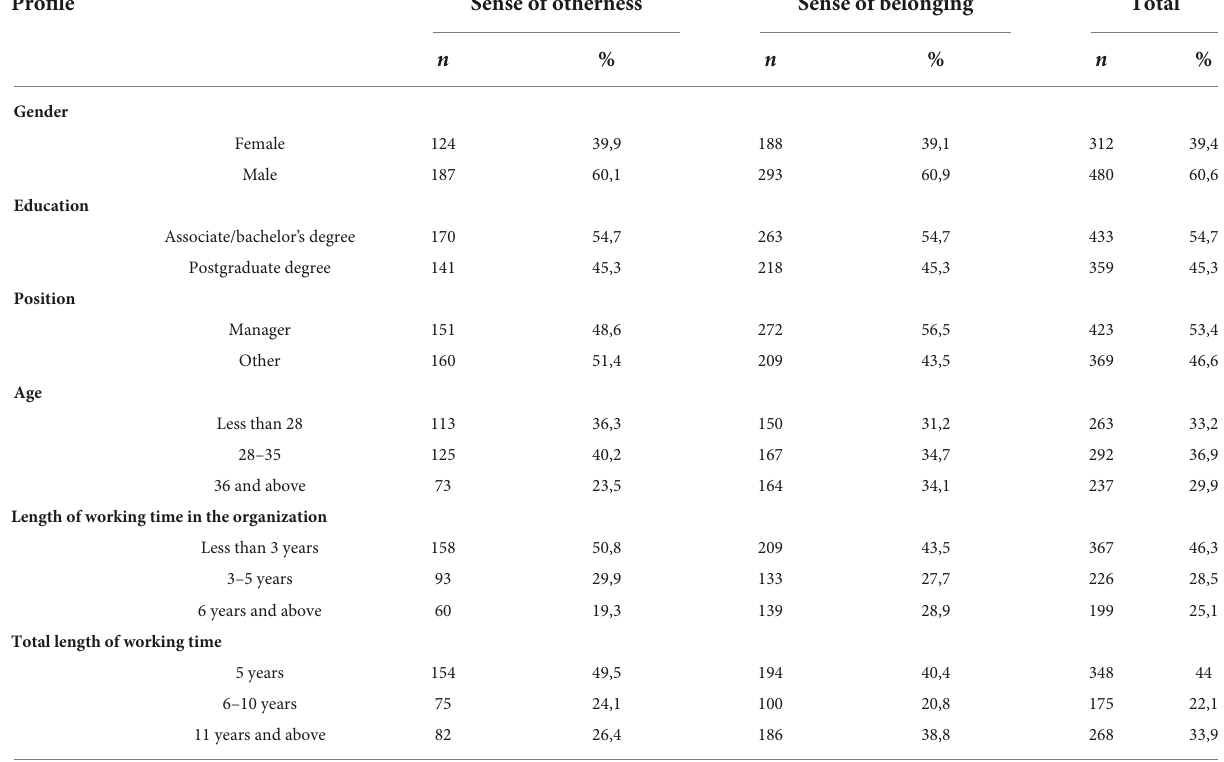
TABLE 1 Demographic profile of the respondents.